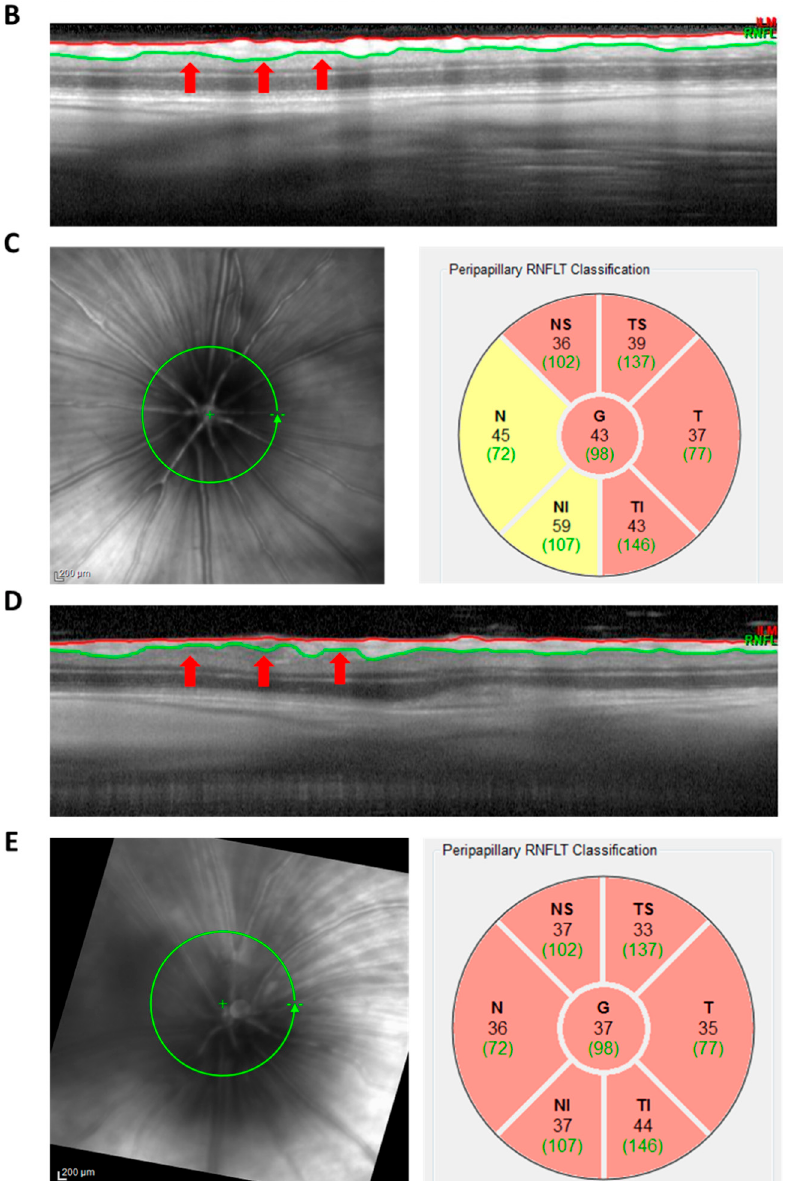
Figure A2. Analysis of OCT images. The OCT is acquired in the form of circular B-scans with 12° diameter. The B-scan consists of 1536 A-scans (cross-sections) acquired along the circle. The linear cross-section shown is the consecutive sequence of these A-scans. The RNFLT is identified in the first step by an algorithm which was developed for human eyes and therefore requires manual adjustment (white arrows, A ). This results in a defined region marked by the inner limiting membrane (red) and the lower border of the RNFL (green) ( B ). The B-scan shown is the baseline examination of the OS of the IgG group. ( C ) RNFL quantification of the region shown in ( B ). The circular B-scan around the peripapillary region ( C , left) is divided by the Heidelberg Eye Explorer software into six segments, for each of which the RNFL thickness is calculated ( C , right). In addition, the average total RNFL thickness is calculated ( C , right, G). ( D ) B-scan of week 10 examination of the same animal shown in ( B ). The red arrows indicate regions of RNFL loss. ( E ) RNFL quantification of the region shown in ( D